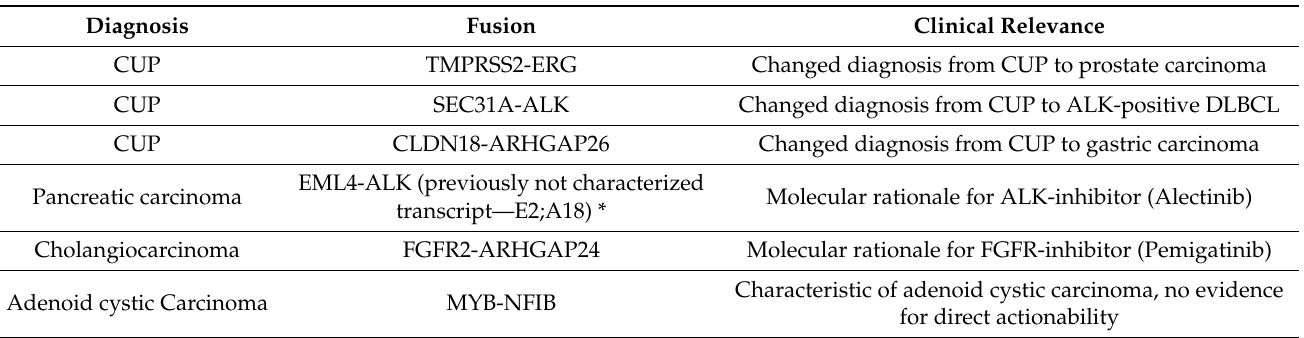
Table 2. Fusion transcripts and respective clinical relevance identified in our MTB cohort.